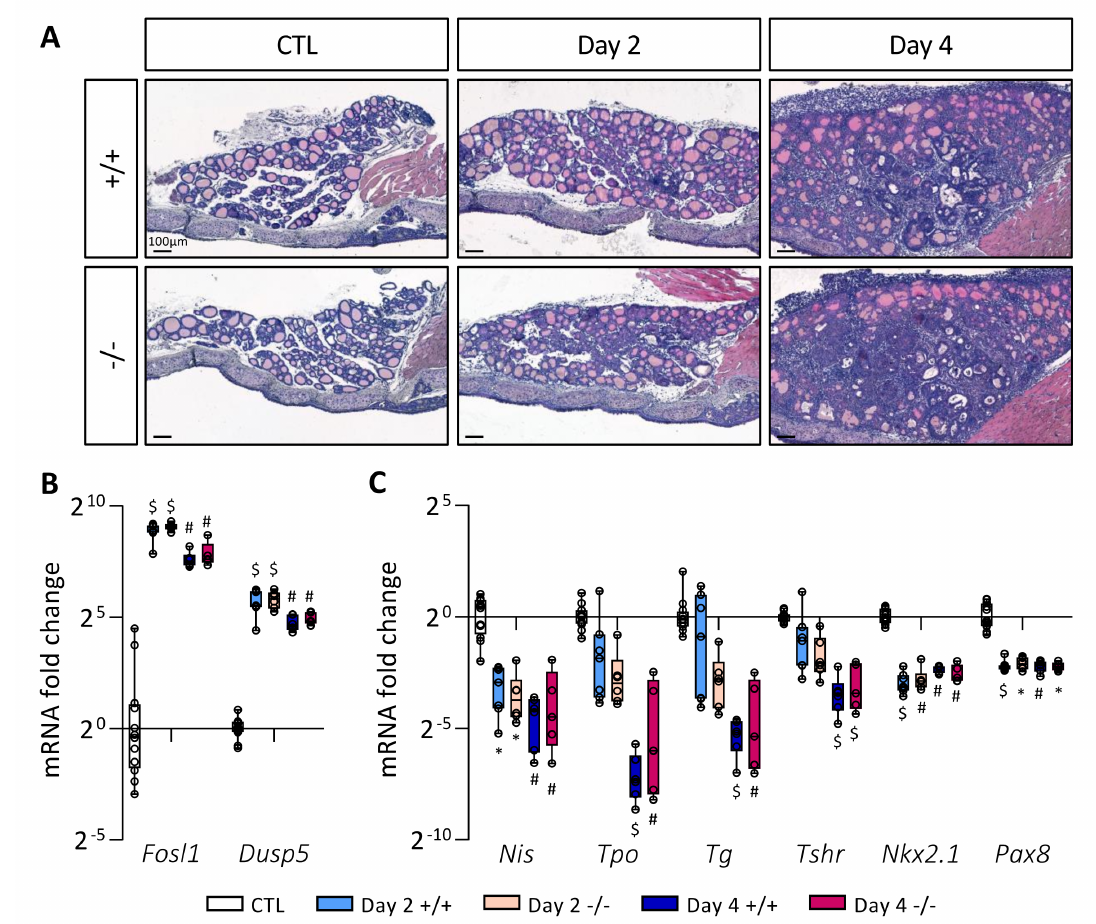
Figure 4. Absence of STABILIN-1 does not affect PTC development triggered by BRAF V600E expres- sion. ( A ) Hematoxylin–eosin staining of thyroid tissue from wildtype (+/+) and knockout ( − / − ) mice treated with doxycycline (Day 2 and Day 4) or not (CTL). ( B , C ) RT-qPCR analyses of two MAPK pathway-target genes (B) and thyroid markers ( C ) in thyroid tissues from wildtype (+/+) and knockout ( − / − ) mice treated with doxycycline (Day 2 and Day 4) or not (CTL) ( n ≥ 5). mRNA fold changes are normalized on the geometric mean of Rpl27 and Gapdh expression and compared to the CTL group (seven +/+ and five − / − thyroid samples). Data are expressed as the mean ± SD (* p < 0.05, # p < 0.01, $ p <